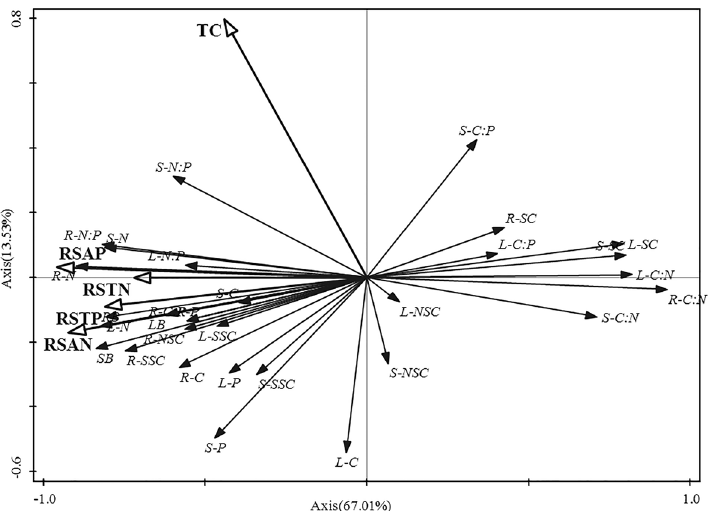
Figure 6. Redundancy analysis (RDA) between soil factors and ecological stoichiometry and NSCs of R. soongorica . RSAP = rhizosphere soil available P, TC = rhizosphere soil total carbon, RSTP = rhizosphere soil total phosphorus, RSTN = rhizosphere soil total nitrogen, RSAN = rhizosphere soil available N, L-SSC = leaf soluble sugar concentration, L-SC = leaf starch concentration, L-NSC = leaf non-structural carbohydrates, L-C = leaf total C, L-N = leaf total N, L-P = leaf total P, L-C:N = leaf C:N ratio, L-C:P = leaf C:P ratio, L-N:P = leaf N:P ratio, LB = leaf biomass, S-SSC = stem soluble sugar concentration, S-SC = stem starch concentration, S-NSC = stem non-structural carbohydrates, S-C = stem total C, S-N = stem total N, S-P = stem total P, S-C:N = stem C:N ratio, S-C:P = stem C:P ratio, S-N:P = stem N:P ratio, SB = stem biomass, R-SSC = root soluble sugar concentration, R-SC = root starch concentration, R-NSC = root non-structural carbohydrates, R-C = root total C, R-N = root total N, R-P = root total P, R-C:N = root C:N ratio, R-C:P = root C:P ratio, R-N:P = root N:P ratio, RB = root